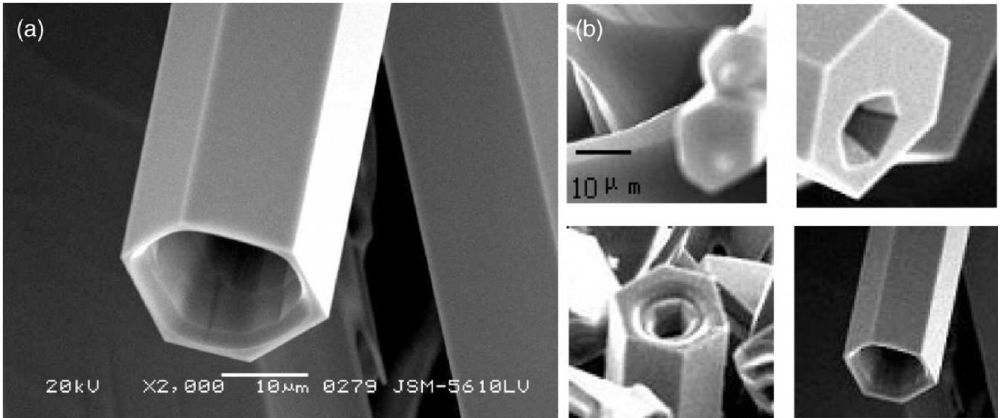
Table 13. Summary of synthesis of pure ZnO by the microwave hybrid method.